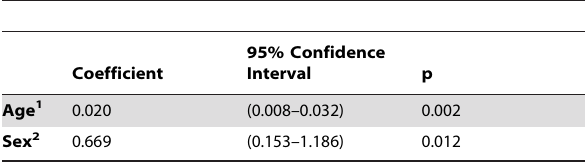
Table 2. Linear regression model of time to become negative by age and sex, Kabak, 2012.